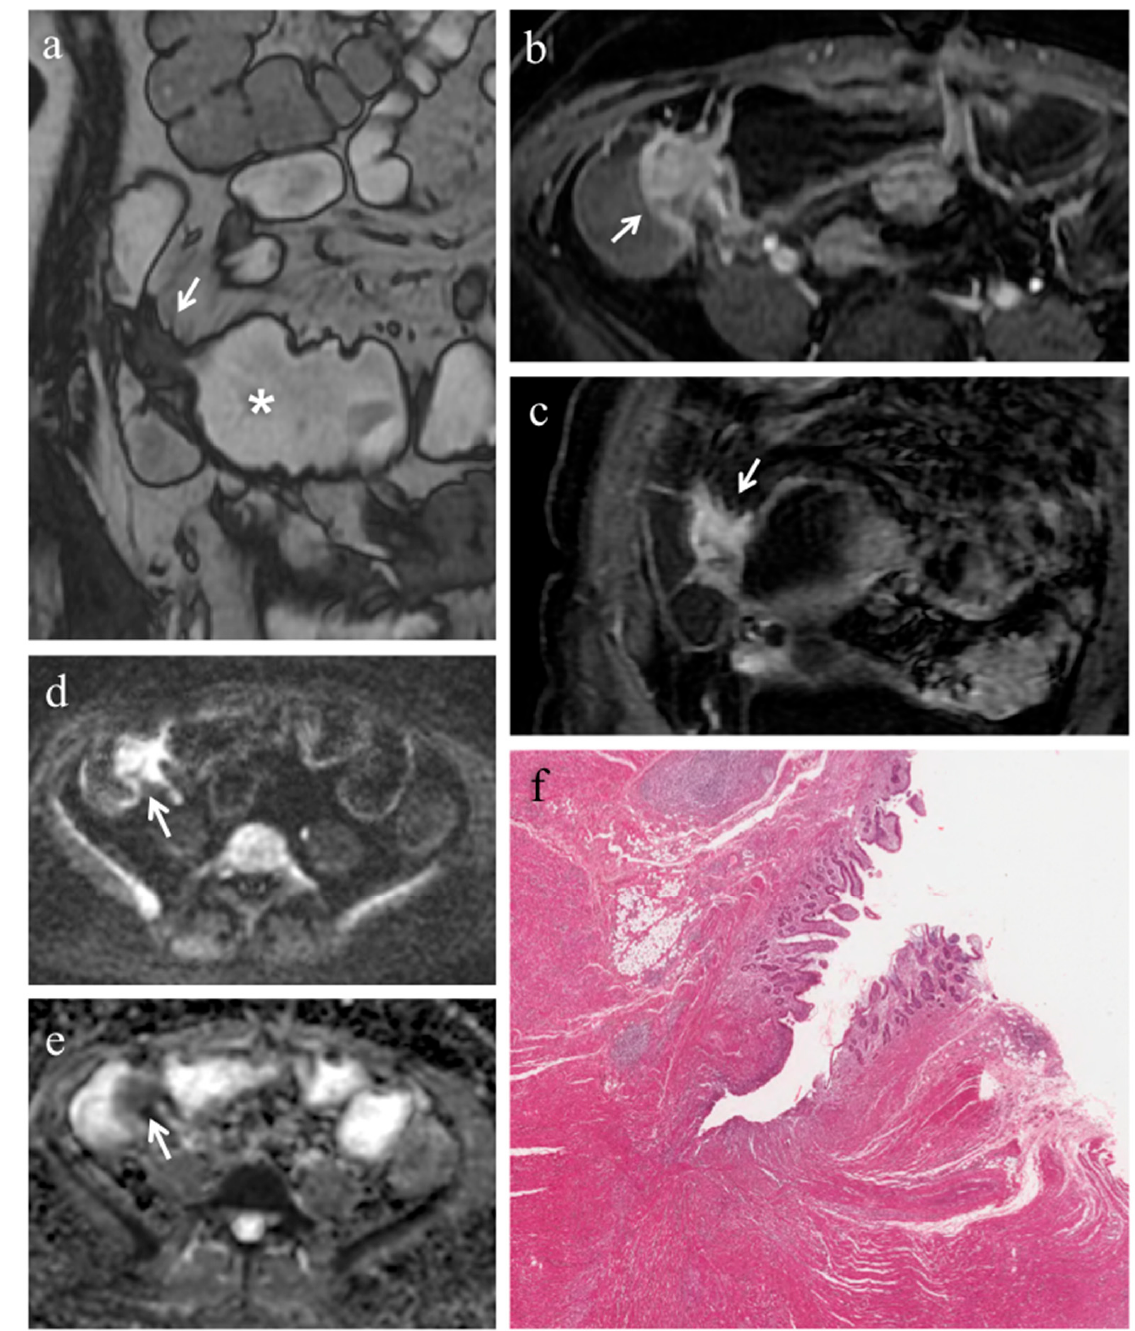
Figure 1. ( a – f ). MRE in a 49-year-old woman with CD: severe predominantly fibrotic stricture of the terminal ileum. ( a ) Coronal fast imaging employing steady state acquisition (FIESTA) image shows wall thickening with noticeable narrowing of the lumen in the terminal ileum (white arrow); note the dilatation (>30 mm) of the upstream bowel loop (white asterisk). ( b ) Axial and ( c ) coronal contrast-enhanced fat-suppressed T1-weighted images demonstrate homogeneous enhancement of terminal ileum (white arrows). ( d ) Axial DW image (b = 800 s/mm 2 ) and ( e ) corresponding ADC map show the same intestinal segment demonstrating restricted diffusion with high signal intensity (white arrow) on the DWI image and low signal intensity (white arrow) on the ADC map (mean ADC value 0.745 × 10 − 3 mm 2 /s). ( f ) Histopathological section from the ileal stricture: hematoxylin and eosin-stained sample (H&E 10 × ). CD exhibiting severe fibrosis (FS = 2) and moderate inflammation (AIS = 7): muscular layers dissected by dense fibrotic tissue on the left, mucosal ulceration and moderate inflammatory infiltration on the right.